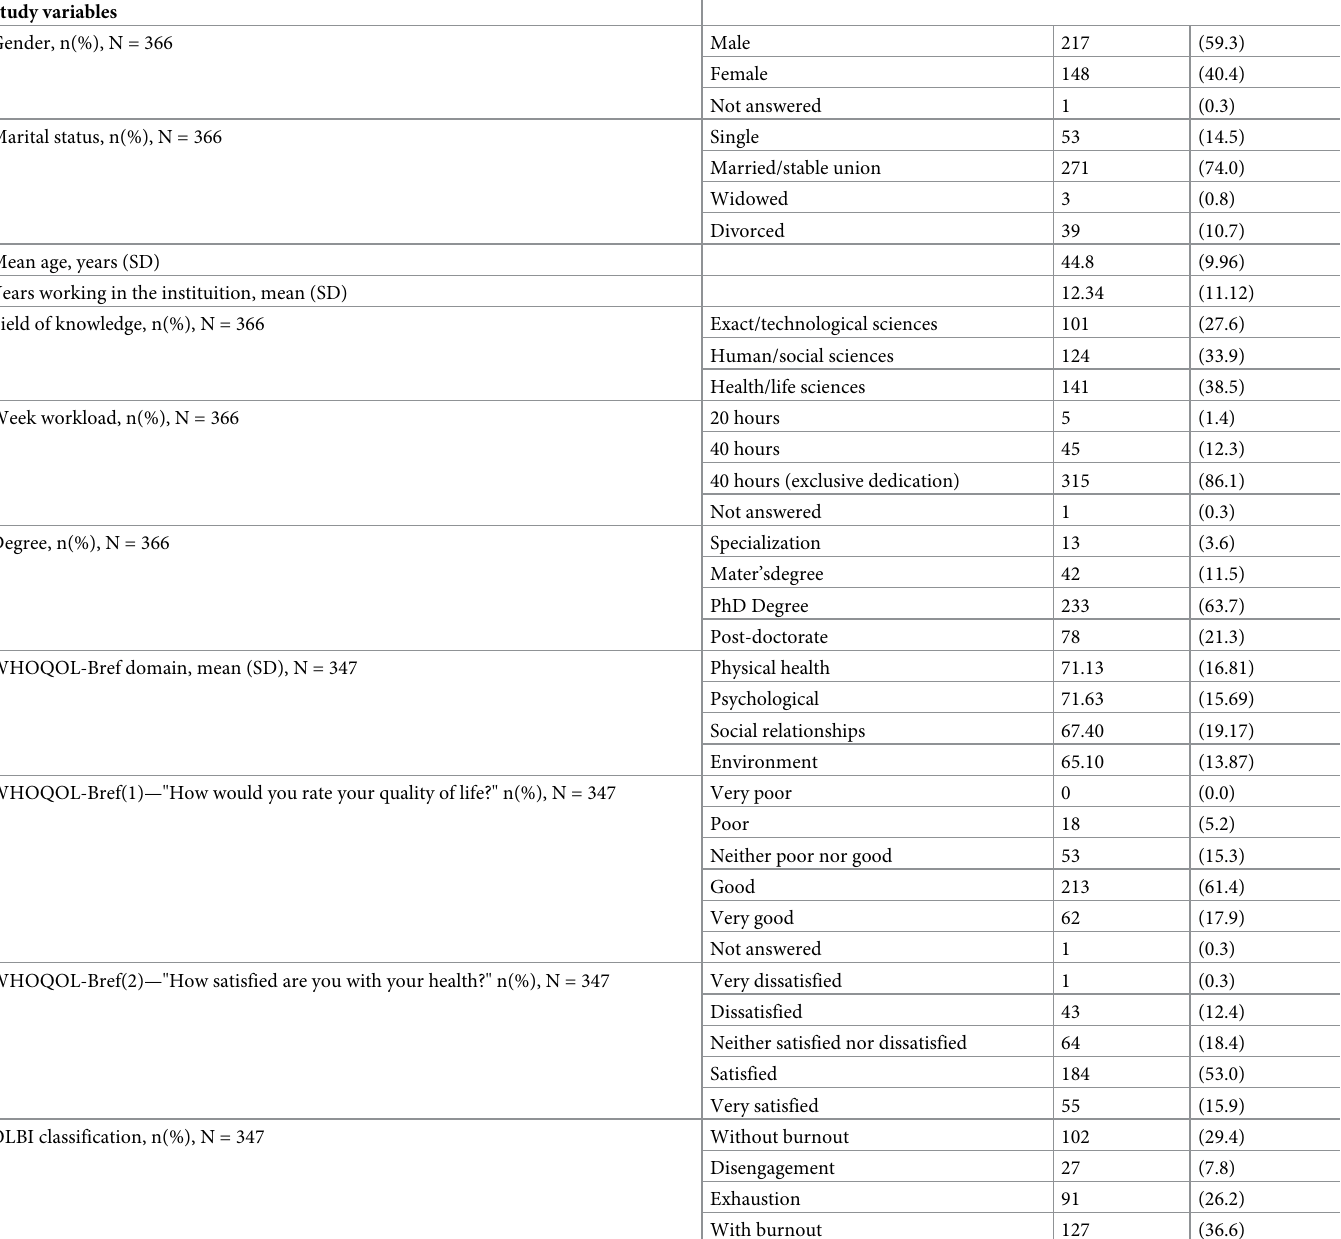
Table 1. Participants’ socio-demographic characteristics, WHOQOL-Bref mean and OLBI